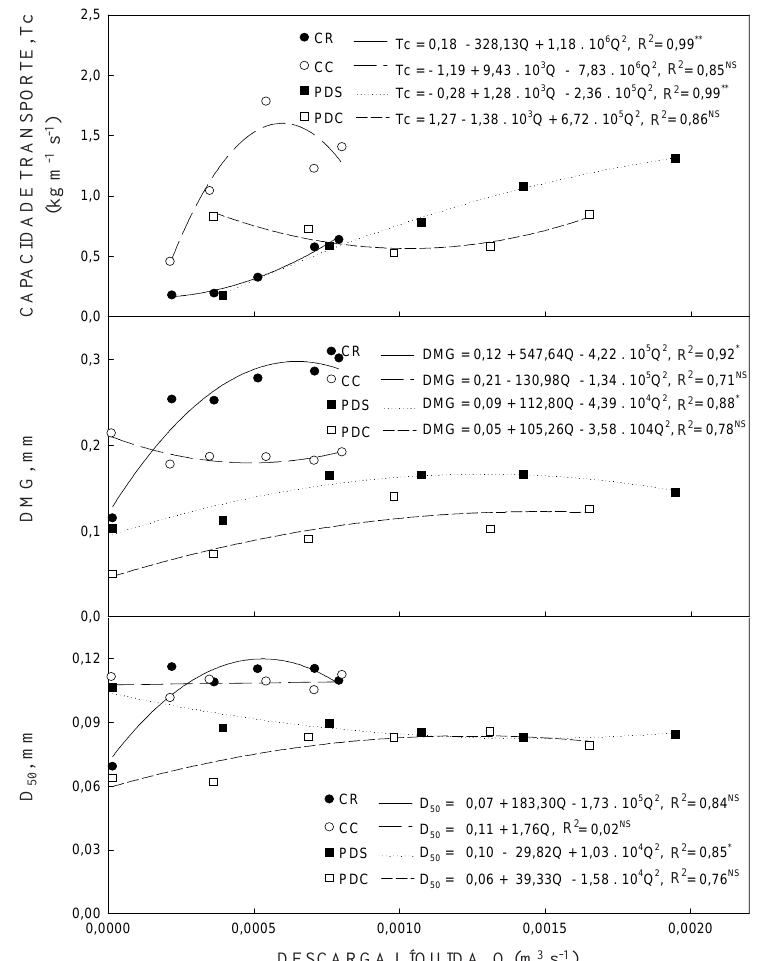
Figura 3. Capacidade de transporte de sedimento (Tc), diâmetro médio geométrico (DMG) e mediano (D ) de sedimentos erodidos e descarga líquida (Q), considerando diferentes preparos e consolidação 50 do solo (CR = convencional recente, CC = convencional consolidado, PDS = plantio direto sem palha, PDC = plantio direto com palha). ** = significativo (P < 0,01); * = significativo (P < 0,05); NS = não-